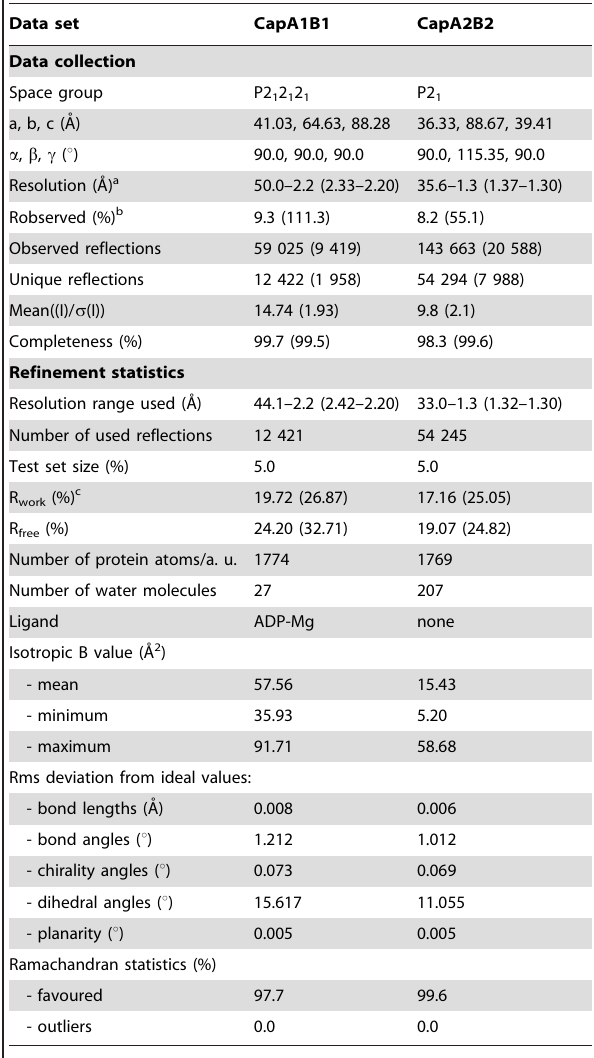
Table 2. Structural